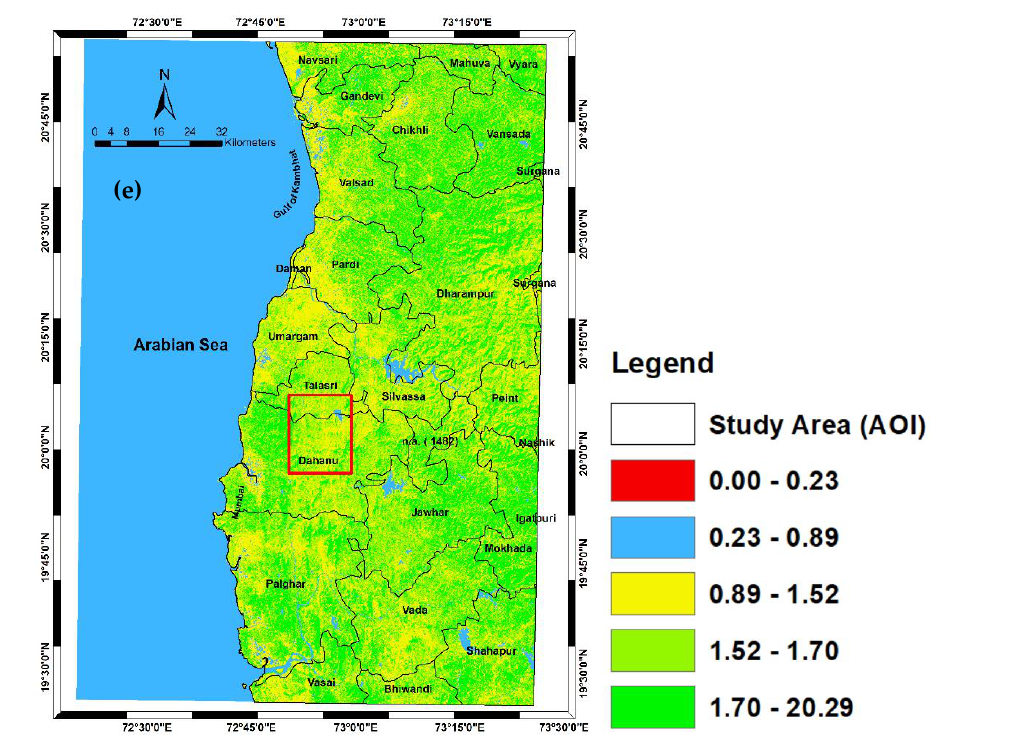
Figure 6. Spatial variation of Soil Moisture over the land and ocean part using Soil Moisture Index (SMI) since 2000-2020; ( a ) SMI status of 2000; ( b ) SMI status of 2015; ( c ) SMI status of 2018; ( d ) SMI status of 2019; ( e ) SMI status of 2020. In each image inside red bounding box represents swarm regions.